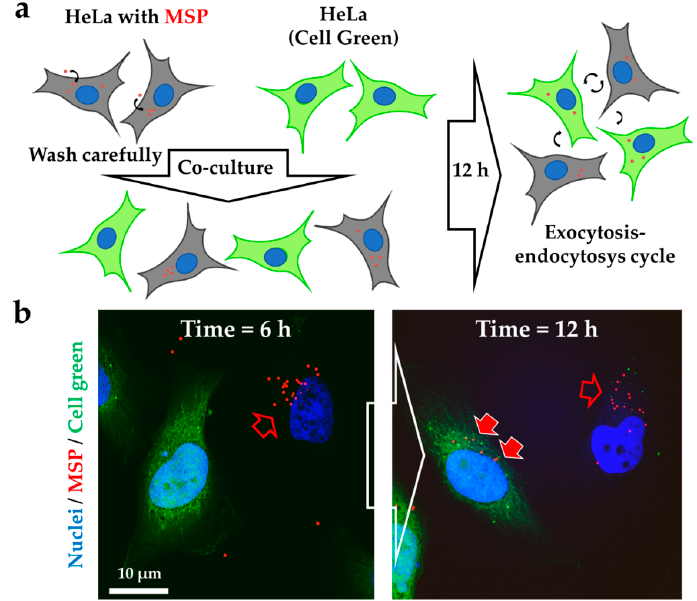
Figure 3. MSP undergo exocytosis–endocytosis cycles. ( a ) Experimental design. Green-labelled ‘empty’ Hela cells were co-cultured with RBITC particle-loaded HeLa cells detached and washed from a different dish (in grey) for 12 h before confocal microscopy imaging. ( b ) Projection images of co-cultured HeLa cells containing intracellular RBITC-labelled MSP (red channel, empty arrows) with green ‘empty’ cells. After 12 h, MSP were detected in the cytoplasm of the green cells (red-filled arrows) demonstrating particle exocytosis and re-endocytosis. Nuclei were stained with Hoescht (blue channel).